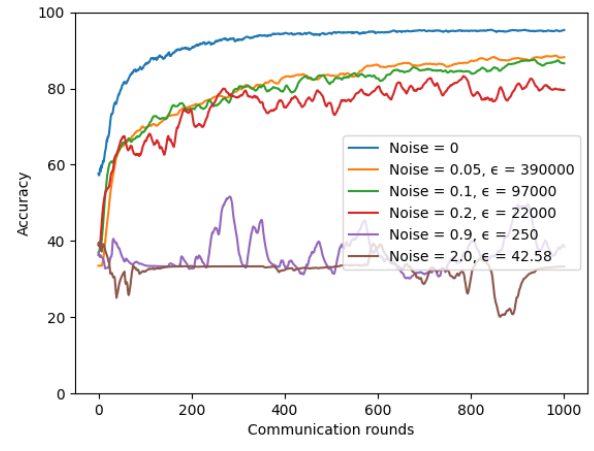
Figure 17. Differential privacy with different noise values on chest X-ray model.